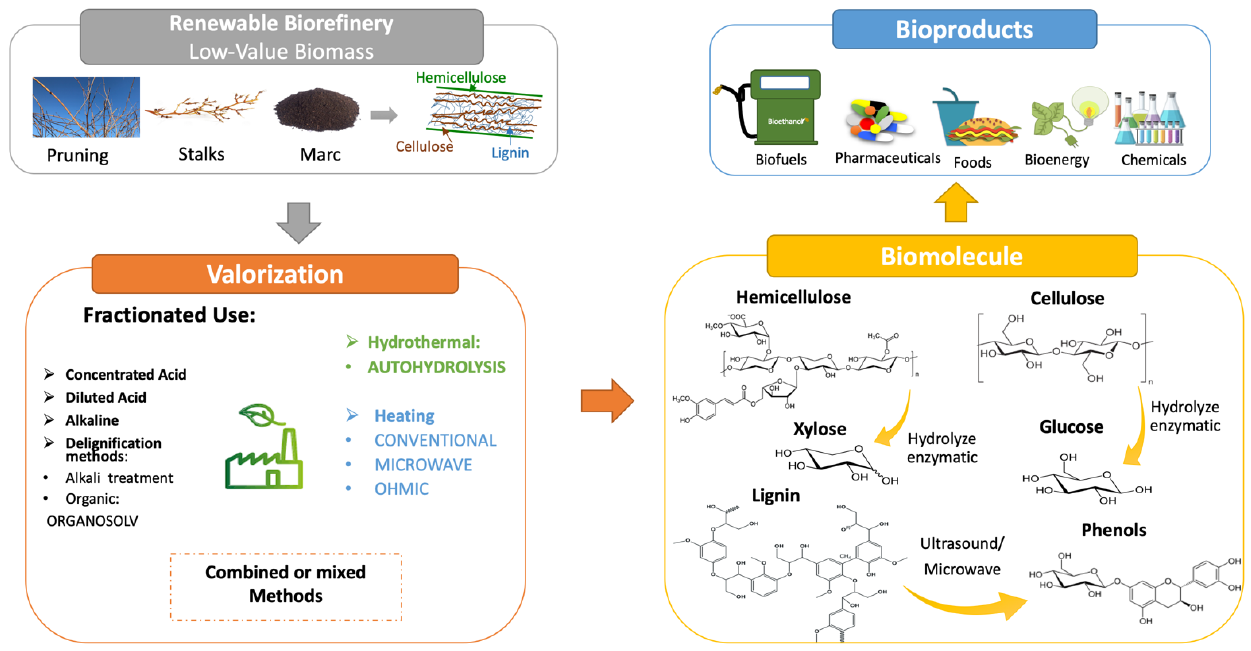
Figure 2. Valorisation of lignocellulosic biomass generated in wine processing following the biorefinery approach.